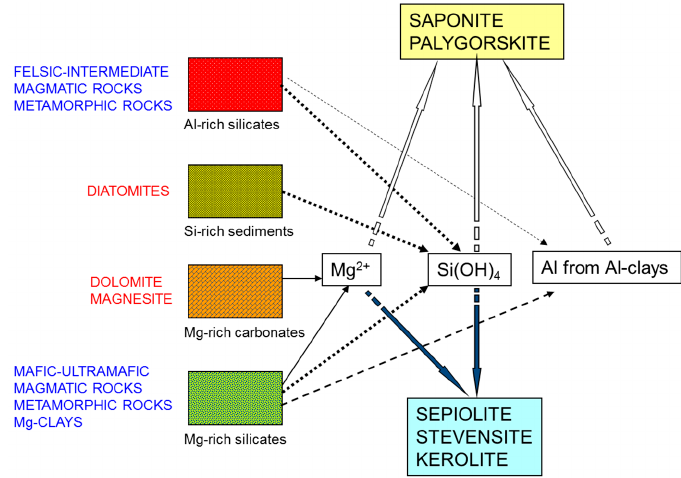
Figure 6. Relationships between types of parent rocks rich in magnesium and silica and the resulting Mg-clays in the sedimentary environment (after [59]).